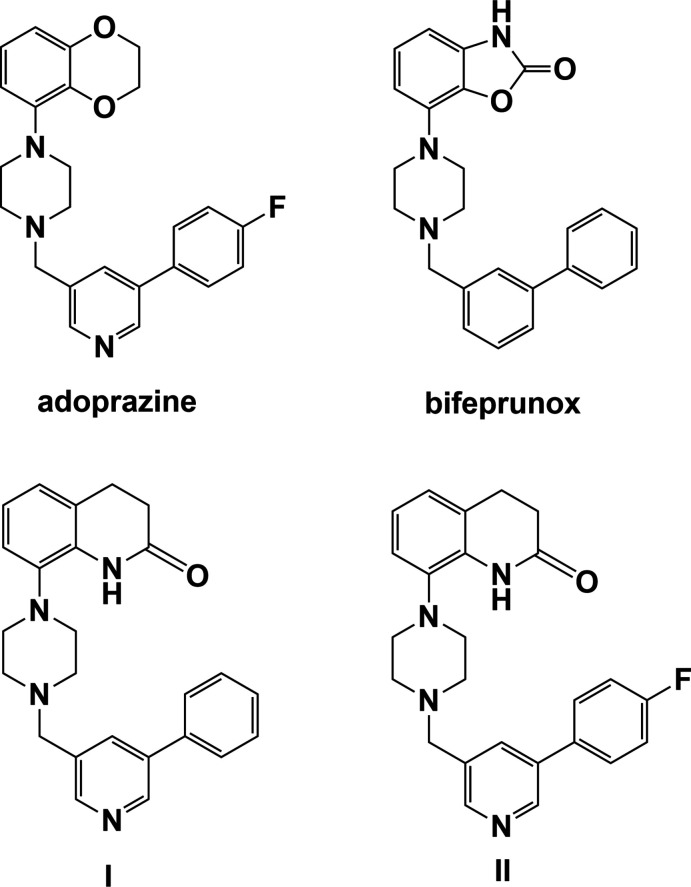
Chemical diagrams for adoprazine, bifeprunoc and compounds I and II.